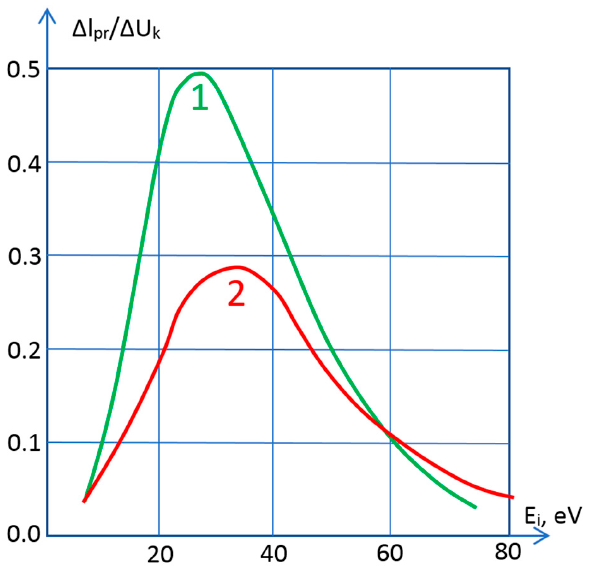
Figure 4. Energy distribution of titanium ions. 1—discharge current of 180 A, 2—discharge current of 300 A.